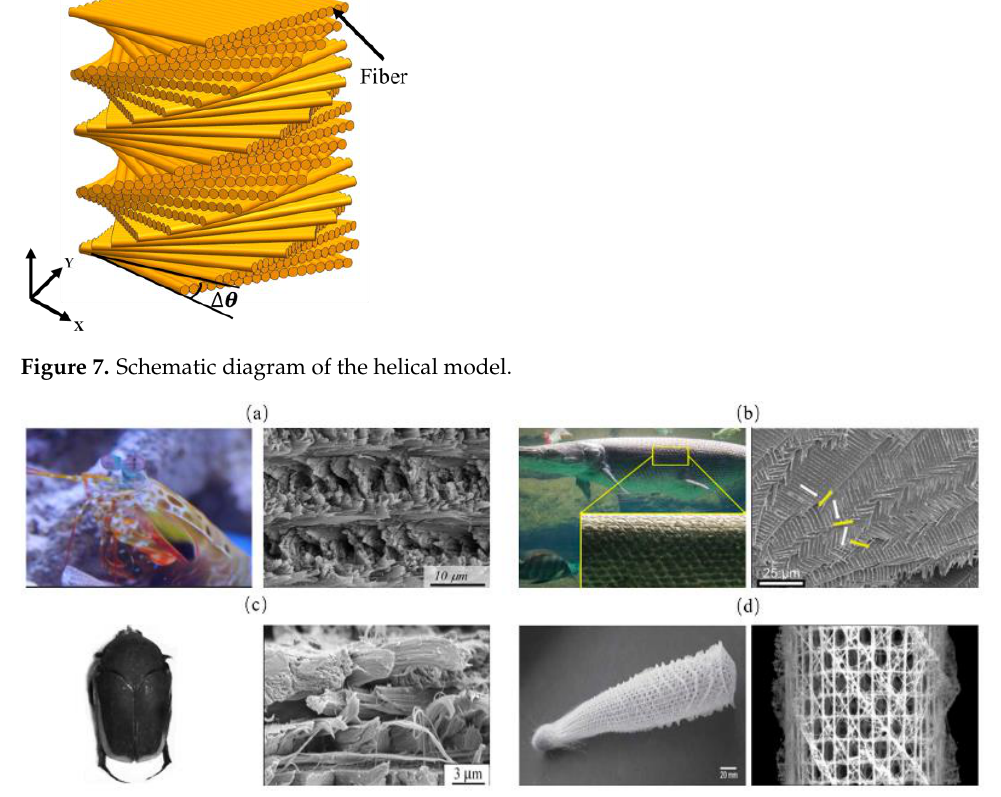
Figure 8. Helical model in of biological organisms. ( a ) mantis shrimp appendage [48] Copyright©2012, Science ( b ) fish scale [49] Copyright©2019, Journal of the Mechanics and Physics of Solids ( c ) beetle exoskeleton [50] Copyright©2019, Acta Biomaterialia ( d ) deep sea sponge [51] Copyright©2007, Progress in Materials Science.